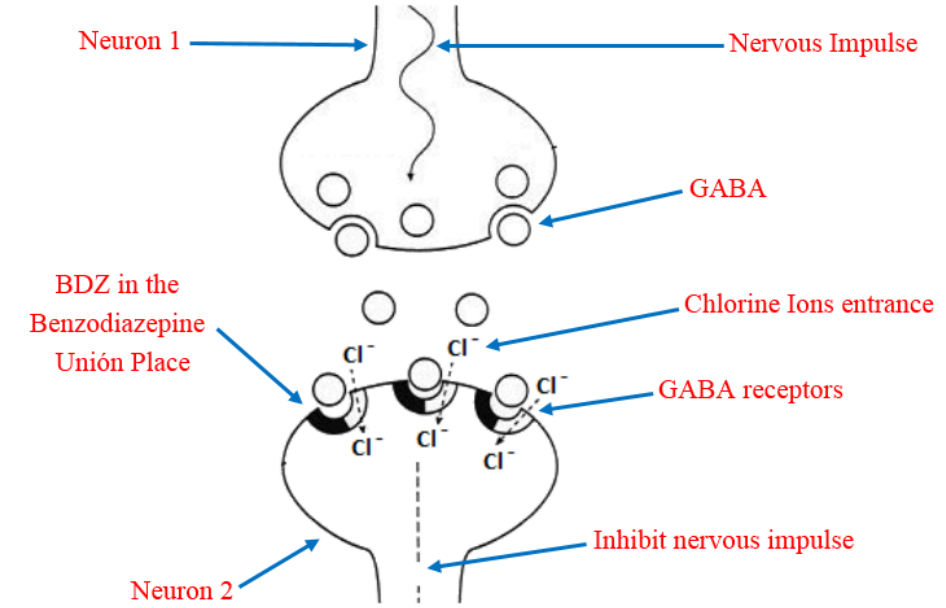
Figure 4. Representation of the benzodiazepines (BDZ) action mechanism and their role in the nervous impulse inhibition. The GABA neurotransmitter action is decisive in the central nervous system because approximately 40% of neurons respond to its effects, so the reassuring effect is significant.